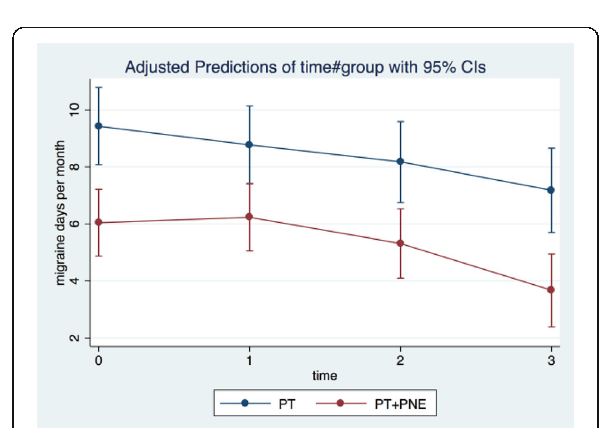
Fig. 2 (abstract P130). See text for